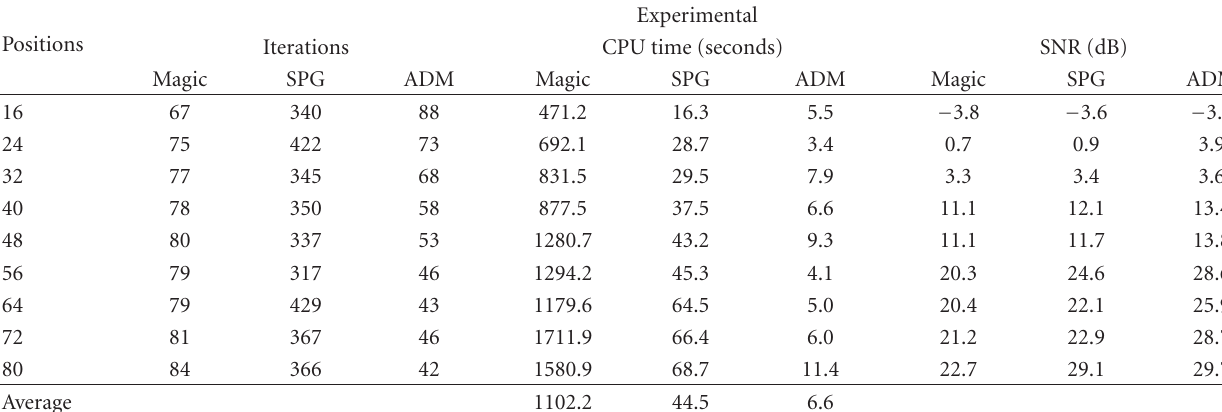
Figure 3: Image reconstructions using the ADM algorithm with 40 detection angles that were uniformly distributed at a 90-degree curve (a) noiseless observation; noisy observation with (b) SNR = 30 dB; (c) SNR = 20dB; (d) SNR = 10 dB. Table 1: Numerical results for L1magic, SPGL1, and ADM methods on PAI images with di ff erent sampling angles and 64 Fourier samples per angle uniformly covering the 90-degree